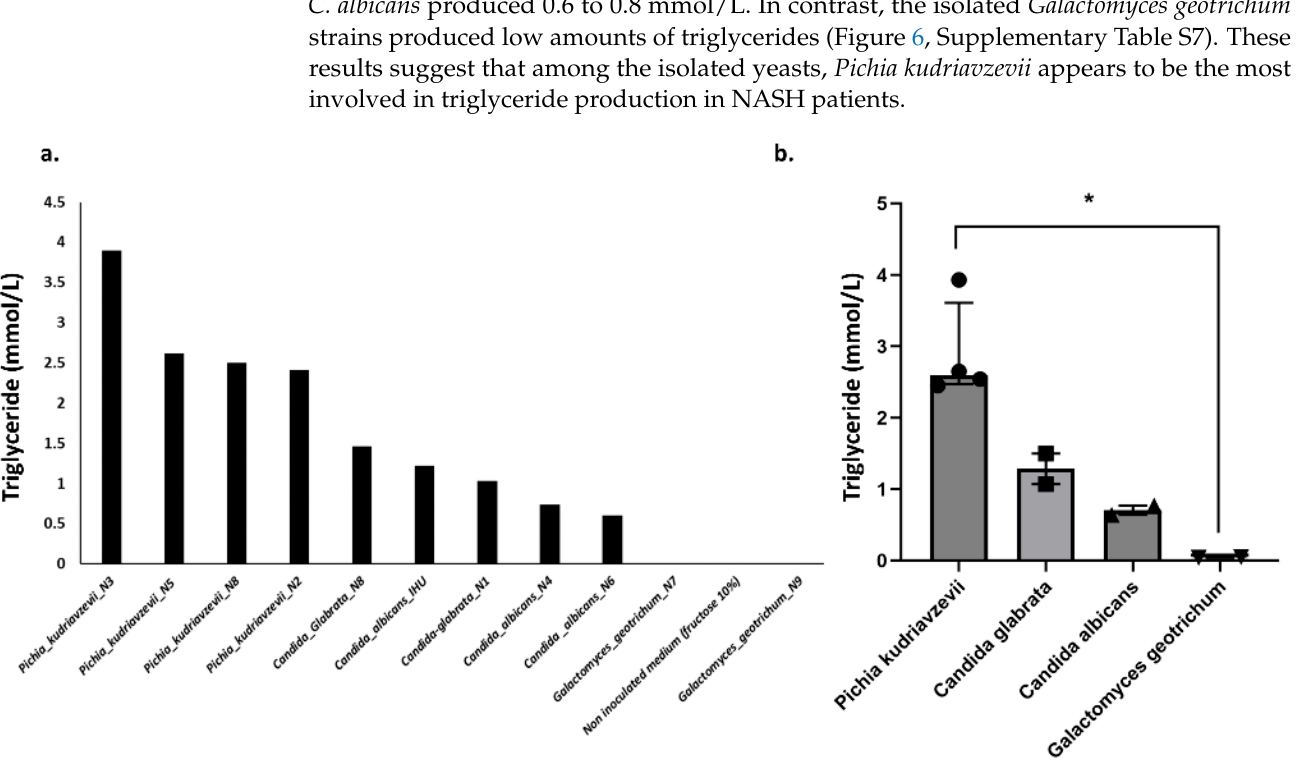
Figure 6. Triglyceride production by yeast strains. A value of 0.036 mmol/L was measured for ultrapure water and considered the background value. The values provided in the figure took into account this background value. ( a ) Triglyceride production for each strain, ( b ) Comparison between species. * p < 0.05.